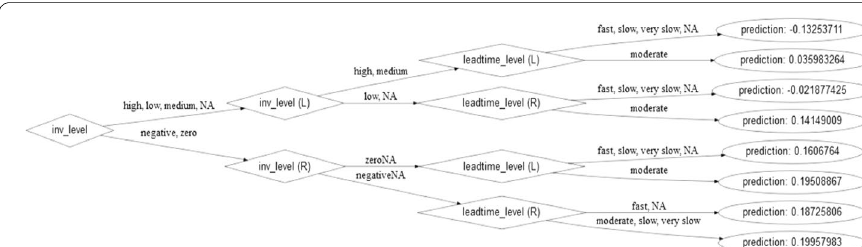
Fig. 14 GBM model’s inventory and lead time level distribution for backorder class